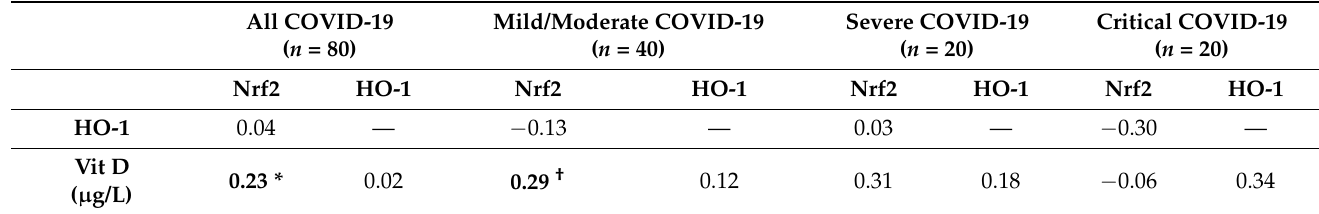
Table 8. Intercorrelations of Nrf2 and HO-1 with 1,25 dihydroxy vitamin